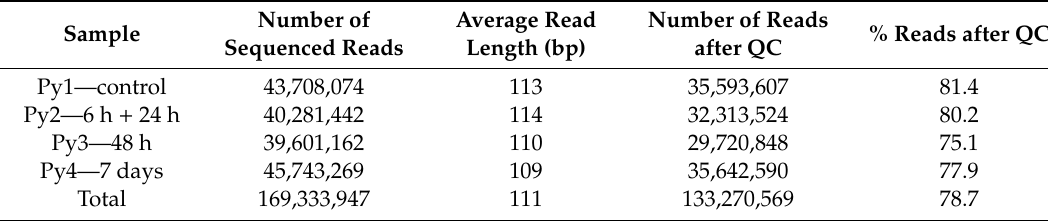
Table 1. Quality control metrics. Number of sequenced reads and the average read length for each library. Number and percentage of processed reads after control quality.